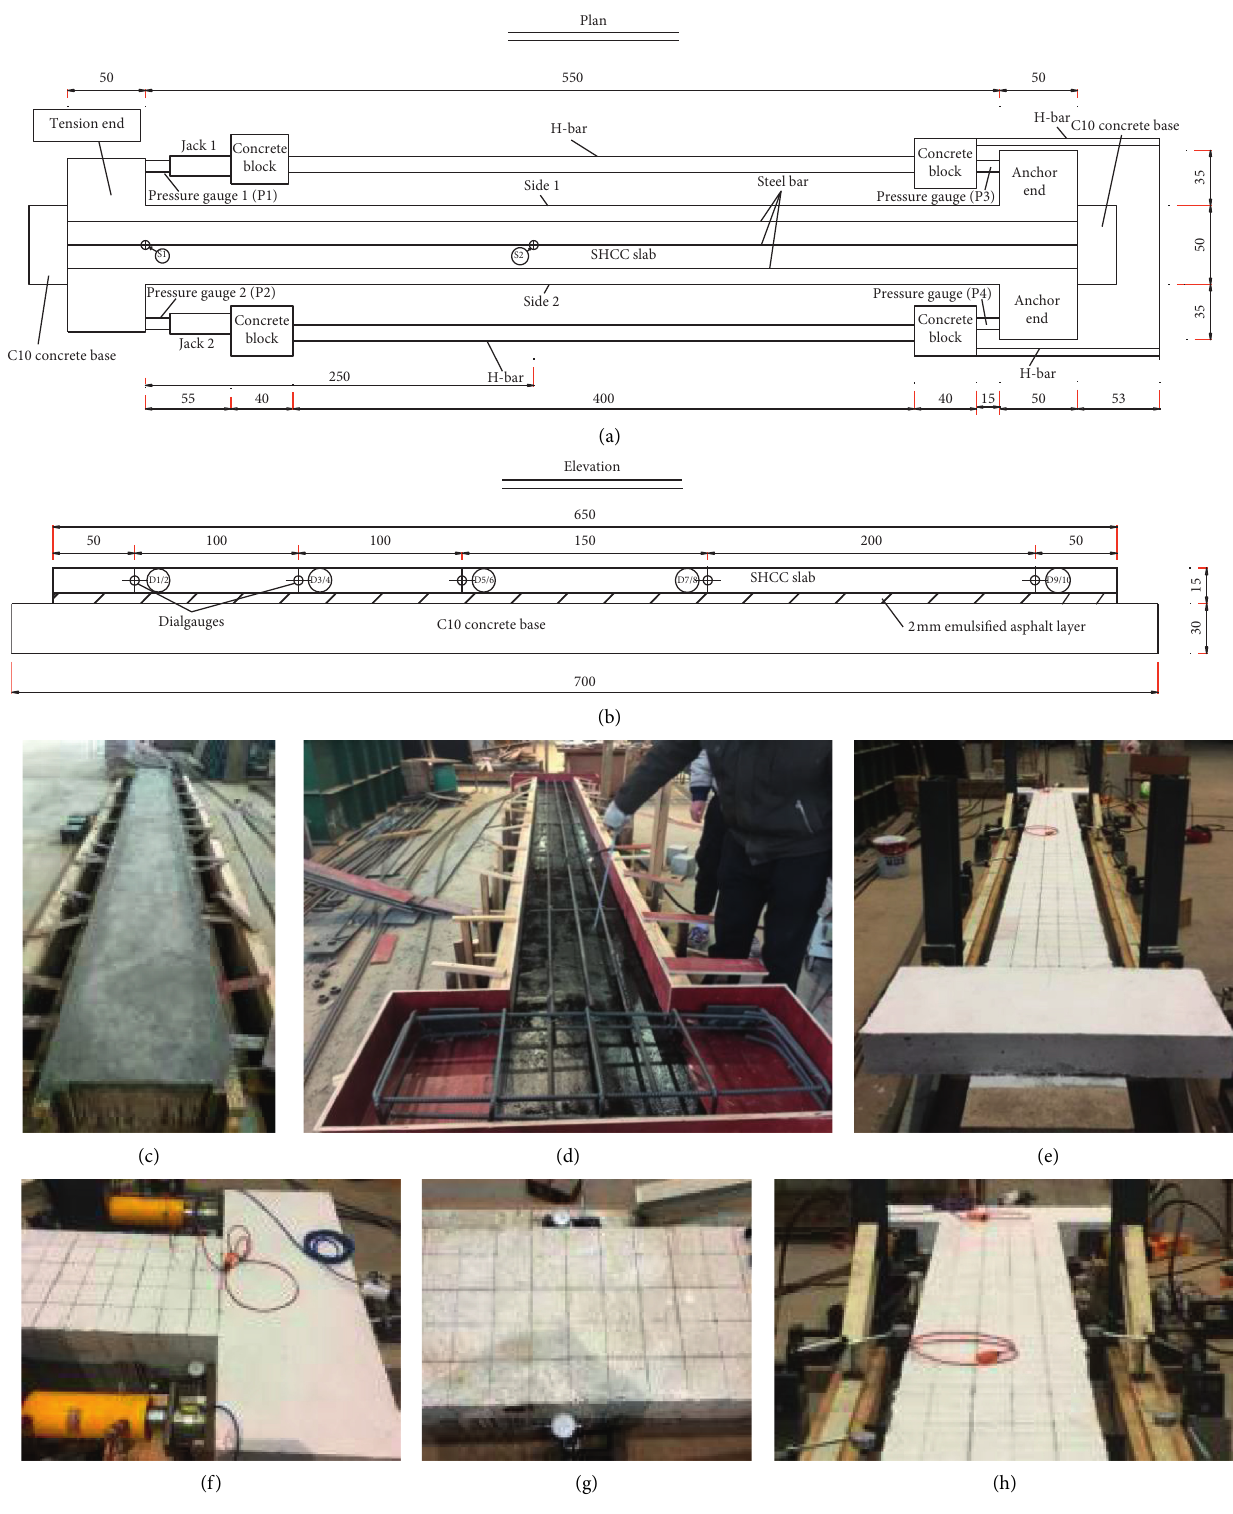
Figure 6: Illustration of the SHCC slab experimental model (unit: cm). (a) Model plan. (b) Model Elevation. (c) C10 concrete base, (d) Laying of the emulsified asphalt sealing layer. (e) Test model. (f) Load diagram. (g) Dial gauges. (h) Strain until the full extension reaches 10 mm. Experiment results longitudinal deformation of the main girder, the displace- and figures of the test were stored for results analysis as ment is controlled by the tension displacement of the SHCC shown in Figure 8(a) and Table 5. slab. Loading displacement is applied in 1 mm increment